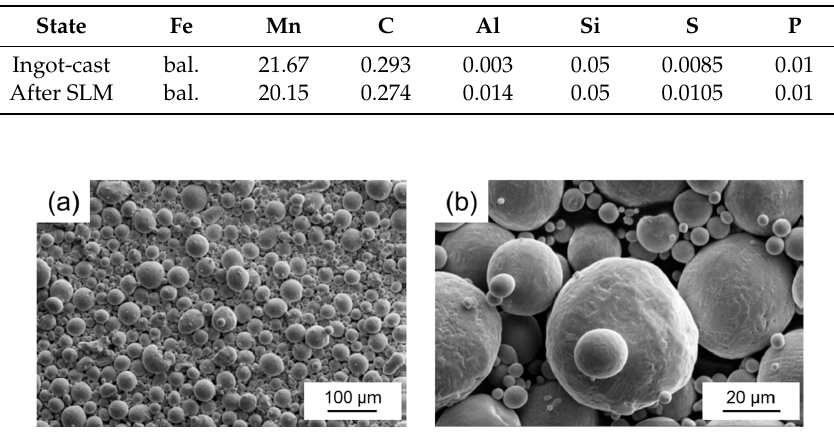
Figure 1. ( a ) Low and ( b ) high magnification SEM image of the prealloyed powder used for sample production by SLM.